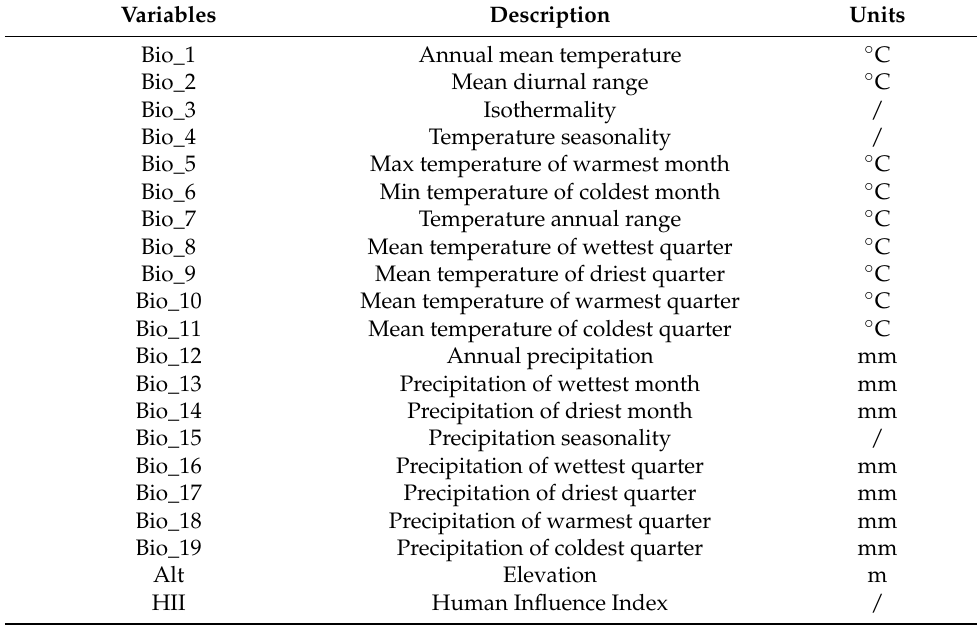
Table 3. Environmental variables for niche model building and climatic niche